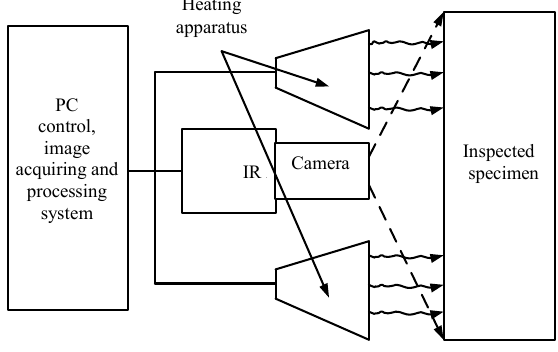
Fig. 2 Pulsed infrared thermography